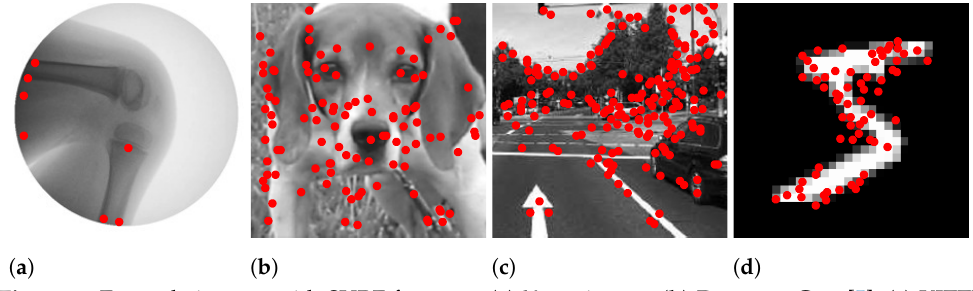
Figure 1. Example images with SURF features. ( a ) X-ray image; ( b ) Dogs vs. Cats [5]; ( c ) KITTI dataset [6]; ( d ) MNIST dataset